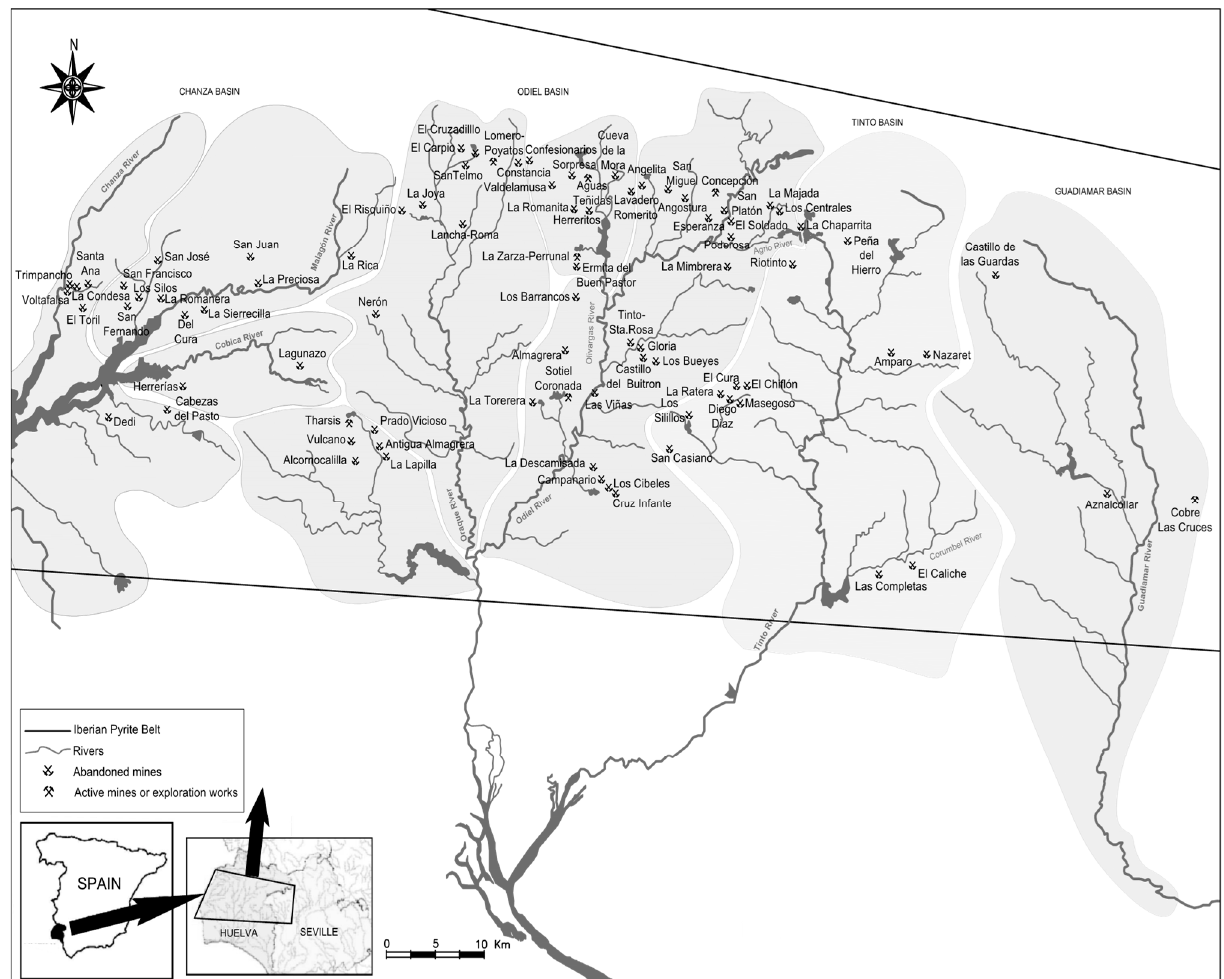
Figure 1. Location map with representation of the river network and the mains mines in the Iberian Pyrite Belt.